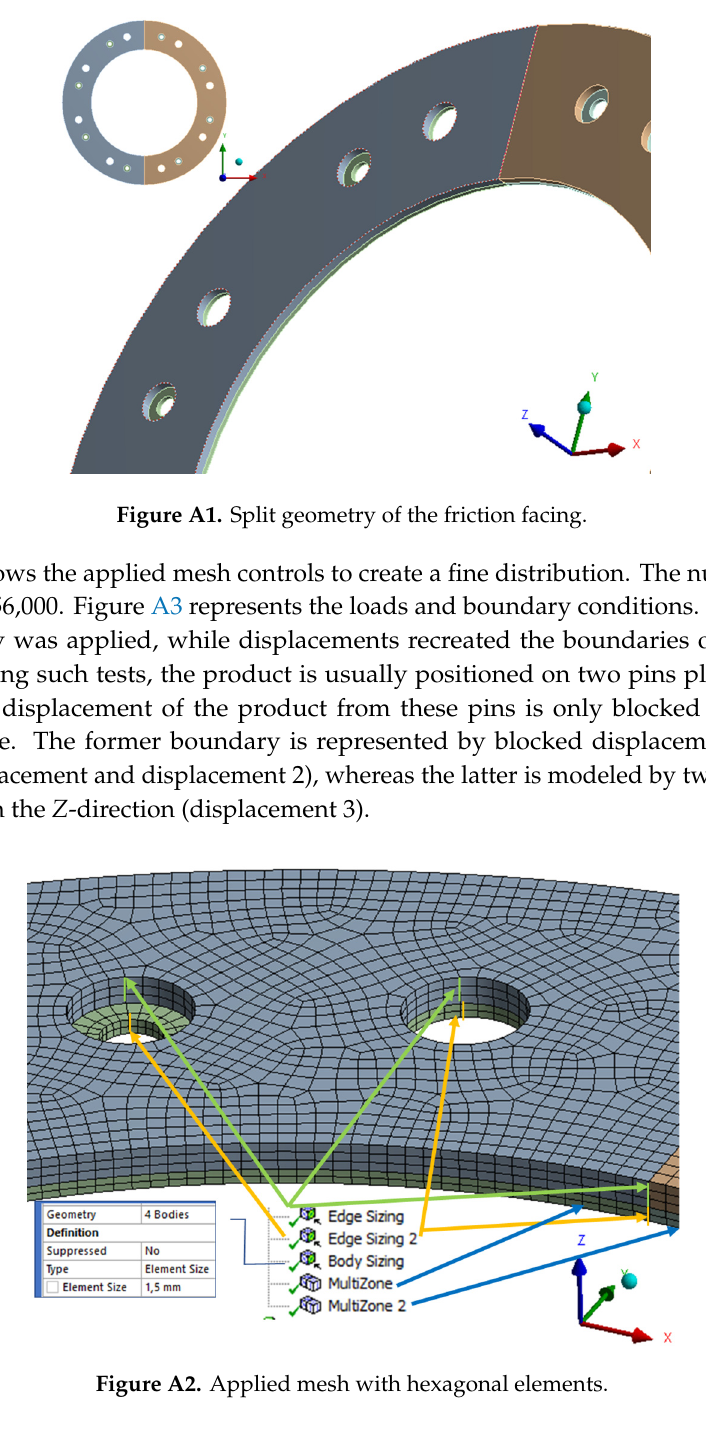
Figure A3. Applied load (rotational velocity, A) and boundary conditions (displacements, B–D). The total deformation and equivalent stress results are presented in Figure A4. The riveting hole gathers stress with discontinuity, while inner radius stresses are usually considered for burst failure.